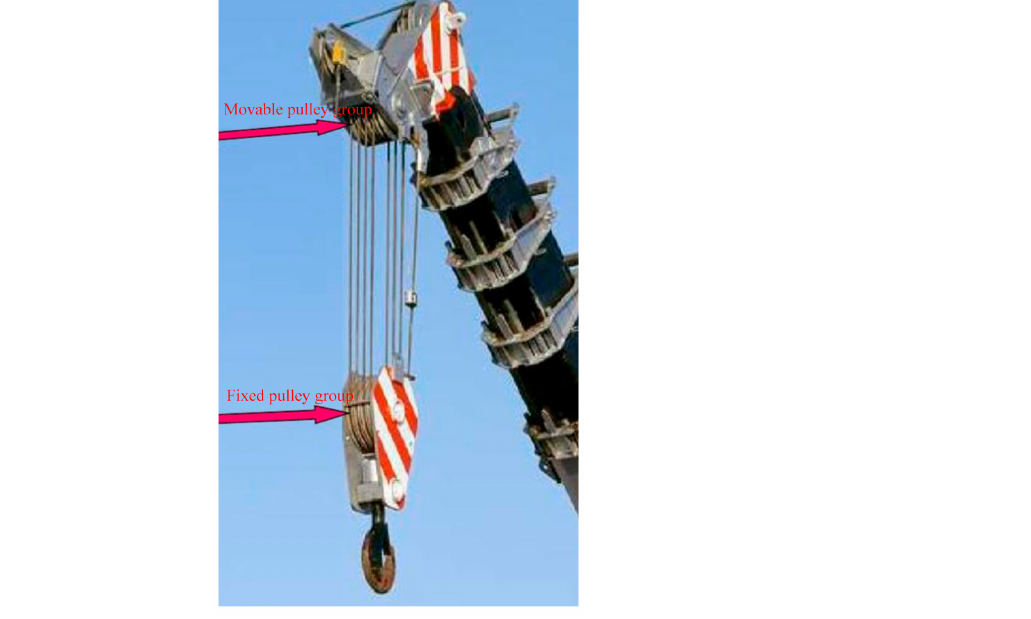
Figure 2. Working conditions of pulley